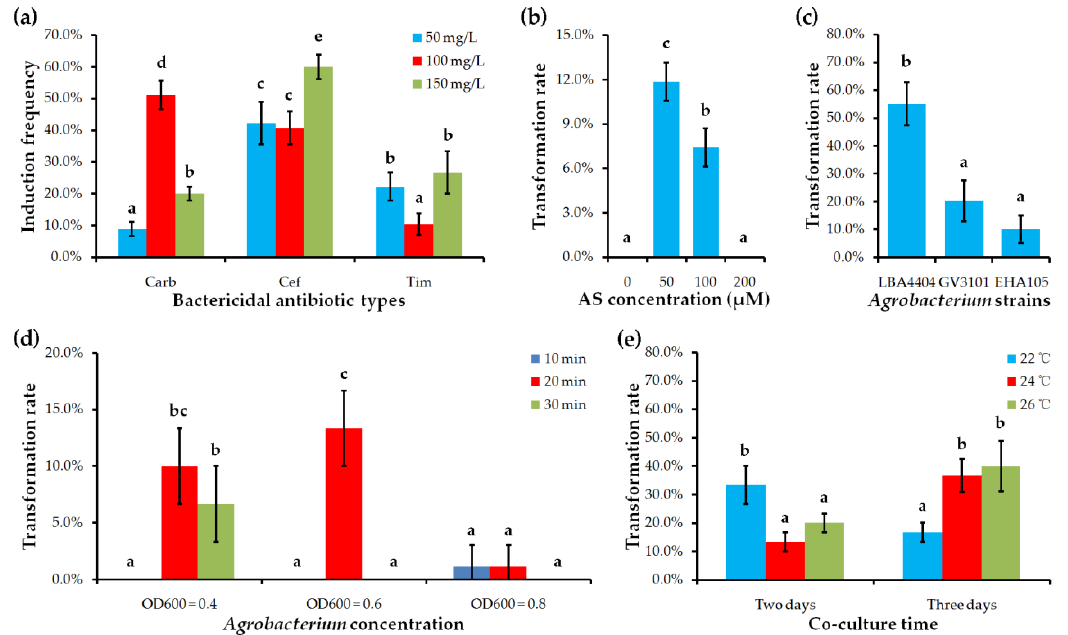
Figure 4. Effect of different factors on transformation rate or shoot induction frequency. ( a ) Bactericidal antibiotic types and their concentrations. ( b ) Acetosyringone (AS) concentration. ( c ) Agrobacterium strains. ( d ) Agrobacterium concentration and incubation time. ( e ) Co-culture time and temperature. Values shown (mean ± standard deviation) are the average of three replicates with each replicate containing 30–45 explants. The difference significance was tested using the LSD test ( p < 0.05) of SPSS 16.0 software (SPSS Inc.). Columns labeled with different letters mean significantly different.